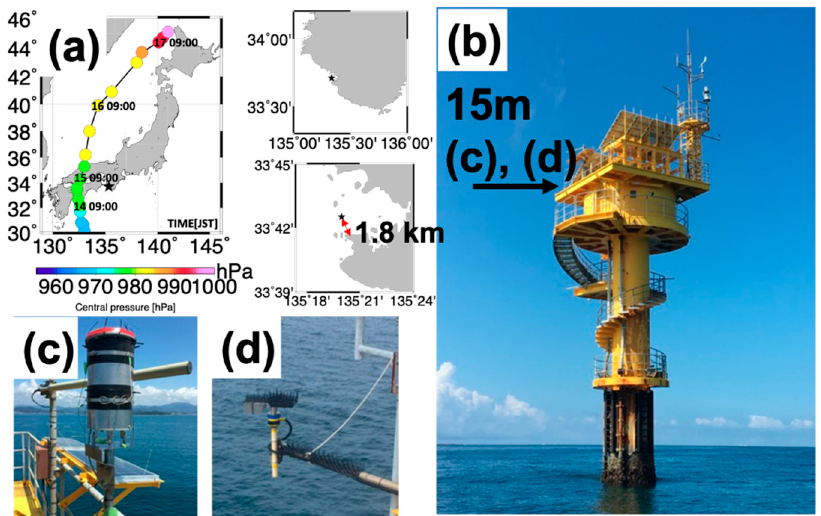
Figure 1. Map of the study area. ( a ) The observation site is indicated by black star. Colored circles indicate the central pressure and track of typhoon Krosa over time (JST). ( b ) The observational tower; the arrow indicates the height of the observation deck (15 m) and positions of the instruments, including ( c ) tipping bucket and ( d ) snow particle counter (SPC).